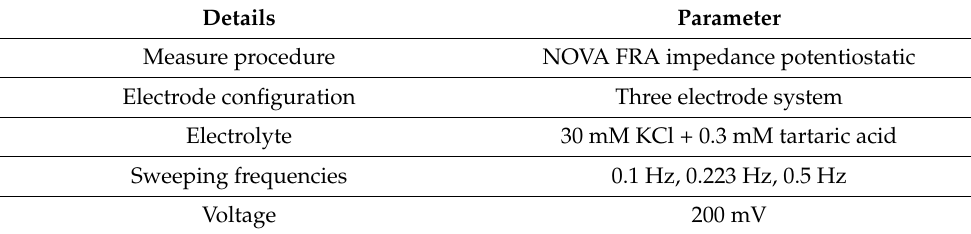
Table 3. Measurement details and parameters of membrane